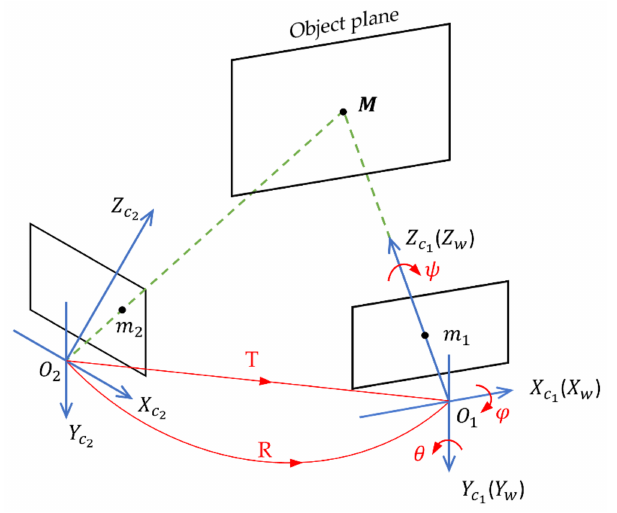
Figure 1. Reference, current camera frames, and involved